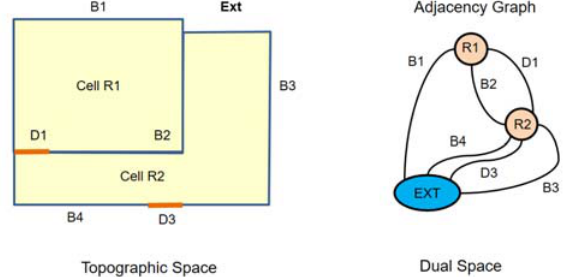
Figure 5. Derivation of adjacency graph from topographic indoor space (OGC